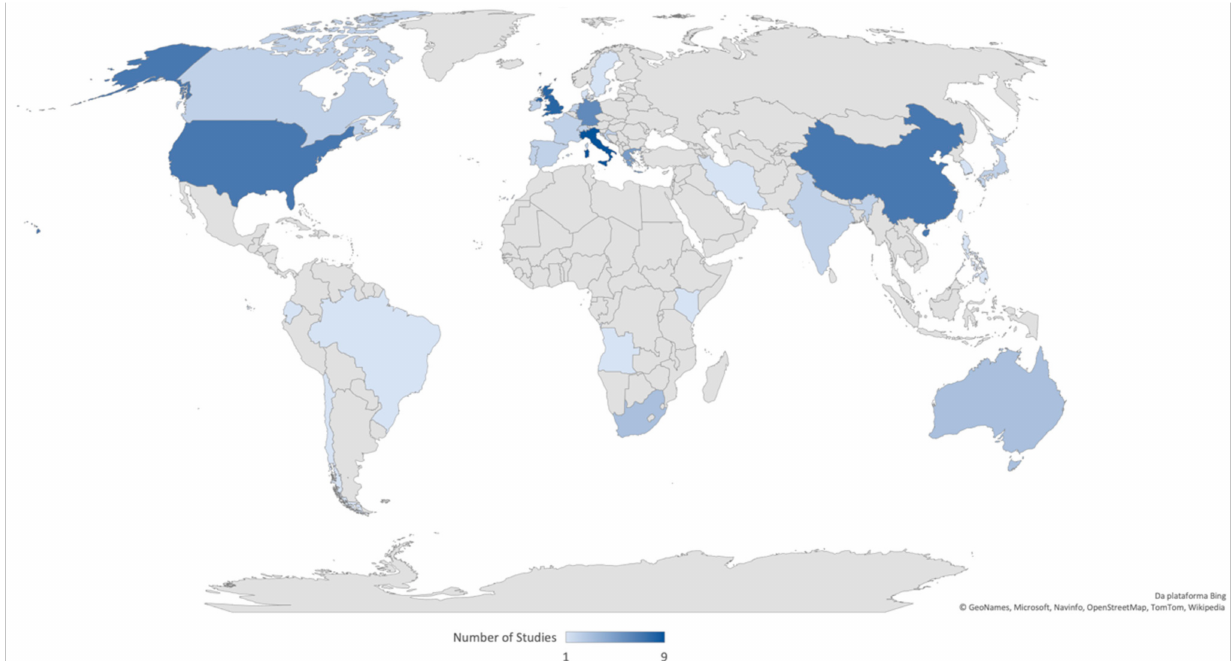
Figure 7. Number of studies by analyzed countries.